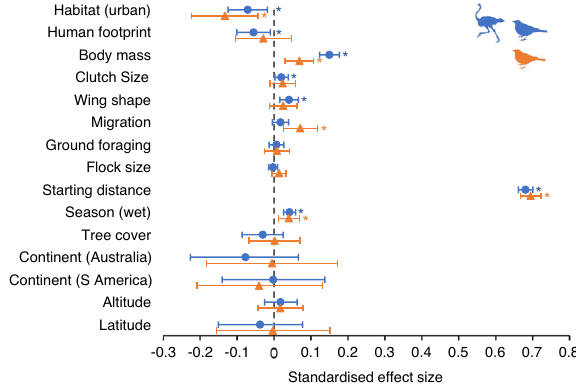
Fig. 2 | Results of multivariate Bayesian phylogenetically- and spatially informed regressions. We evaluated the association between avian tolerance towards humans (measured as the fl ight initiation distance; dependent variable) and several life-history and environmentalpredictors across birds of open tropical ecosystems (all species: blue colour, N =10,249 observations for 842 species; pas- serines: orange colour, 5400 observations for 425 species) and reported standar- dised effect sizes (coloured objects) with their 95% credible intervals (horizontal lines). Predictors included habitat type (rural or urban), human footprint index, body mass, clutch size, wing shape (measured as hand-wing index), presence of migratory behaviour, ground foraging, fl ock size, starting distance, season (wet or dry),percentagetreecover,continent(Africa,AustraliaorSouthAmerica),altitude and latitude. We considered an association signi fi cant if the credible intervals did not overlap zero — statistically signi fi cant results are highlighted by “ * ” . For infor- mation on sample sizes and full statistical results, see Supplementary Table 1. Bird silhouettesweredownloaded